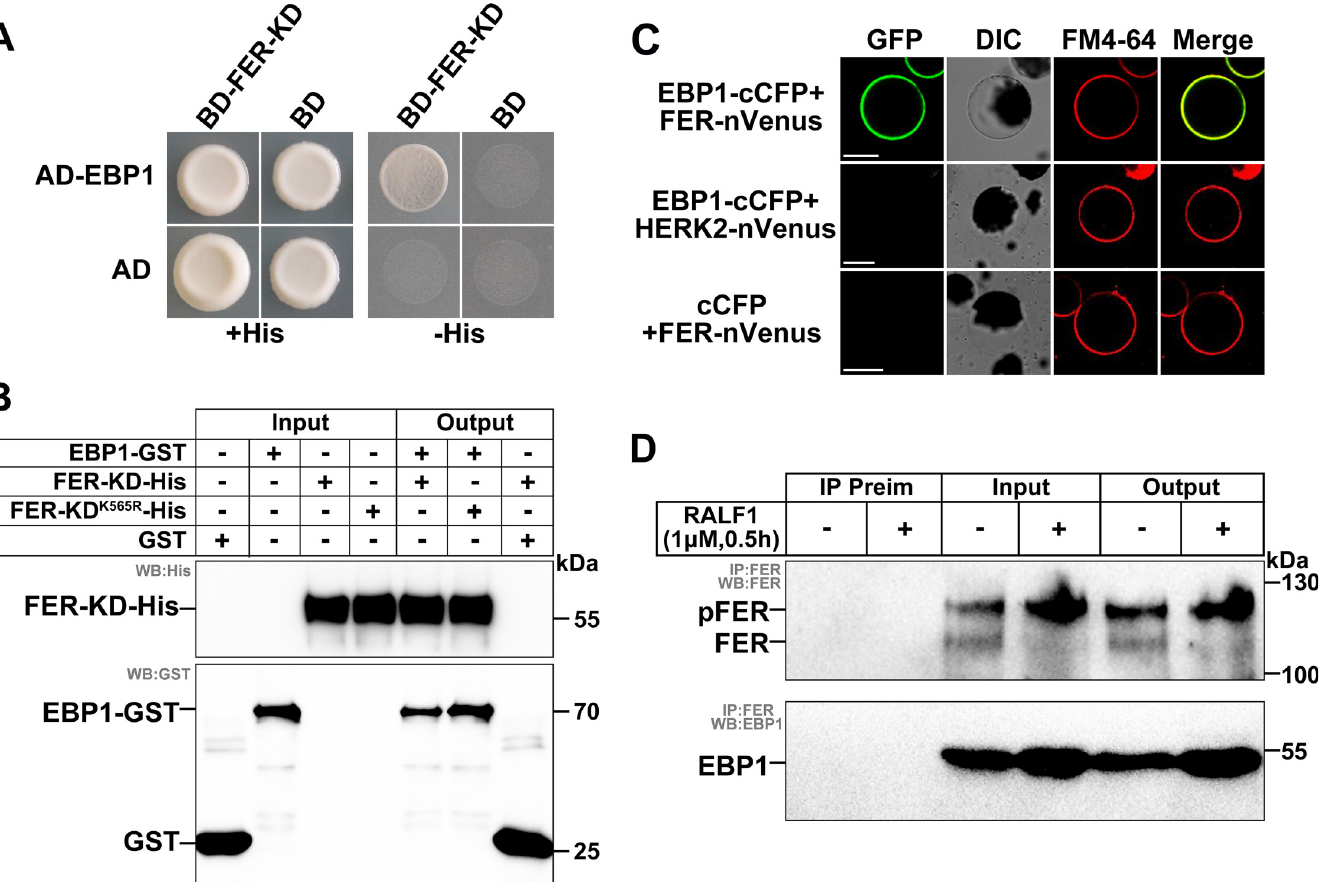
Fig 1. EBP1 physically interacts with FER. (A) Y2H assays show interaction between EBP1 and FER. SD/-Ade/-Leu/-His selection medium containing 20 mM 3-AT was used for screening yeast growth. (B) GST pull-down assays. The indicated GST-tag and His-tag were detected by anti-GST and anti-His, respectively. (C) EBP1 interacts with FER in BiFC assay in Arabidopsis protoplasts. Negative controls (EBP1-cCFP+HERK2-nVenus and cCFP+FER-nVenus) are shown. GFP, FM4-64, DIC, and merged images are shown, bar = 20 μ m. (D) Co-IP assays. The immunoprecipitated FER and coimmunoprecipitated EBP1 were indicated using anti-FER and anti- EBP1 antibodies. pFER indicates the phosphorylated FER. The dephosphorylated form of FER is labeled as FER. Input lanes are indicated. Preimmune serum (“Preim”) was used as negative control. Seedlings were treated with or without 1 μ M RALF1 for 30 minutes. All assays were performed on at least three biological replicates, and similar results were obtained. AD active domain; BD, binding domain; BiFC, bimolecular fluorescence complementation; cCFP, C-terminal cyan fluorescent protein; Co-IP, coimmunoprecipitation; DIC, differential interference contrast; EBP1, ErbB3-binding protein 1; FER, FERONIA; GFP, green fluorescent protein;